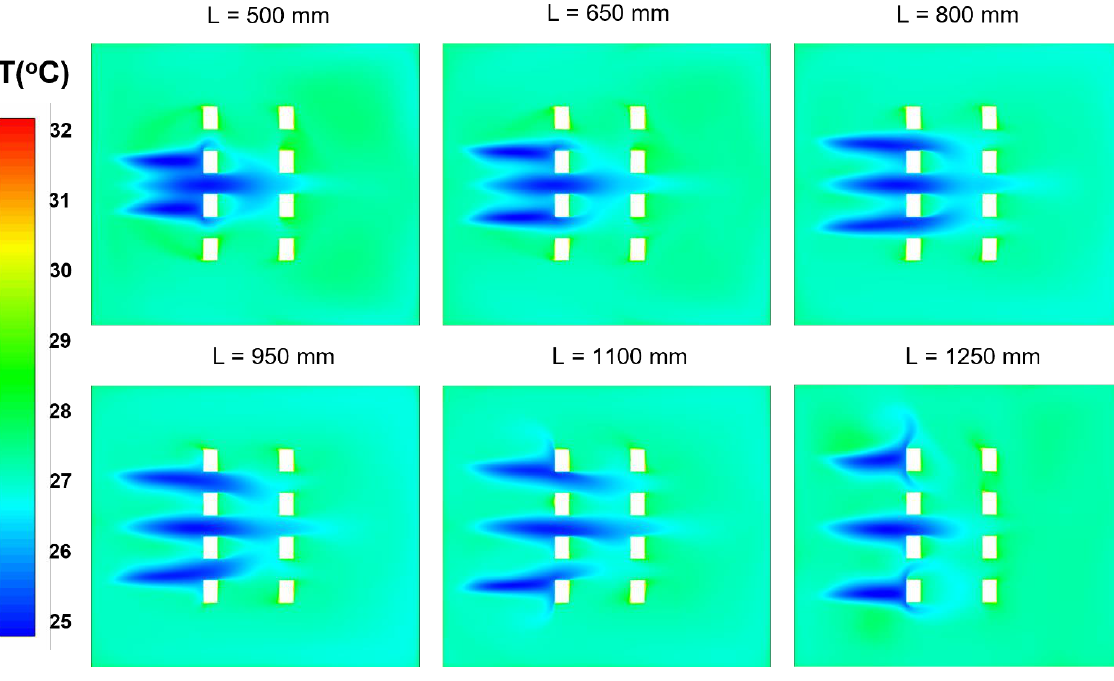
Figure 12. Temperature distribution contour in the plane z = 1.1 m with different air inlet spacings.